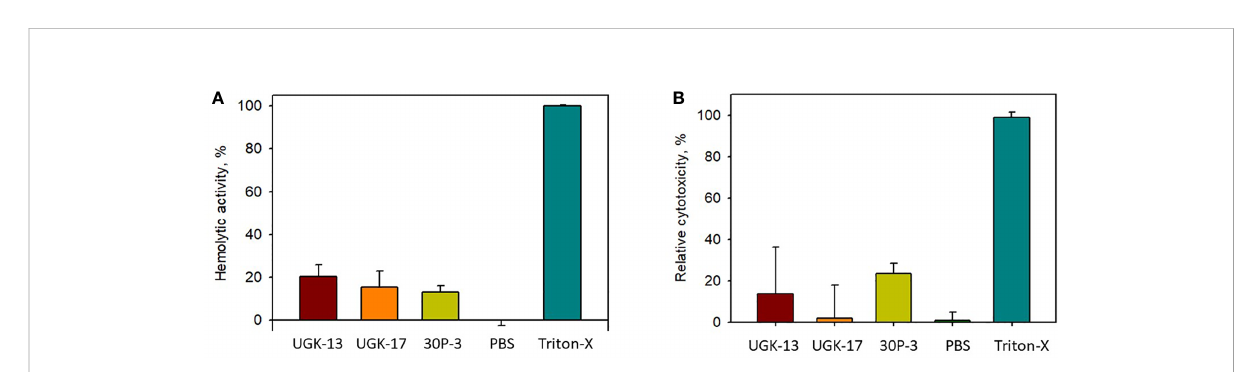
FIGURE 4 Cell viability from treatment with different peptides at 20 m M concentration with the hemolytic (A) and MTT (B) assays.